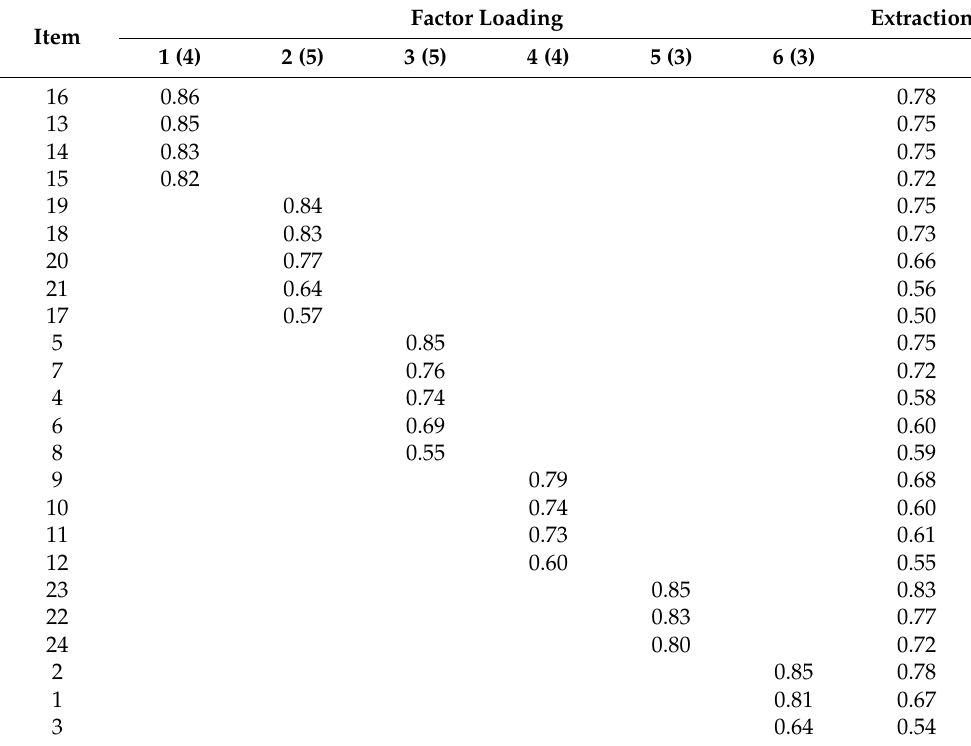
Table 2. Exploratory factor analysis results for the QWLSKT. Factor Loading Item